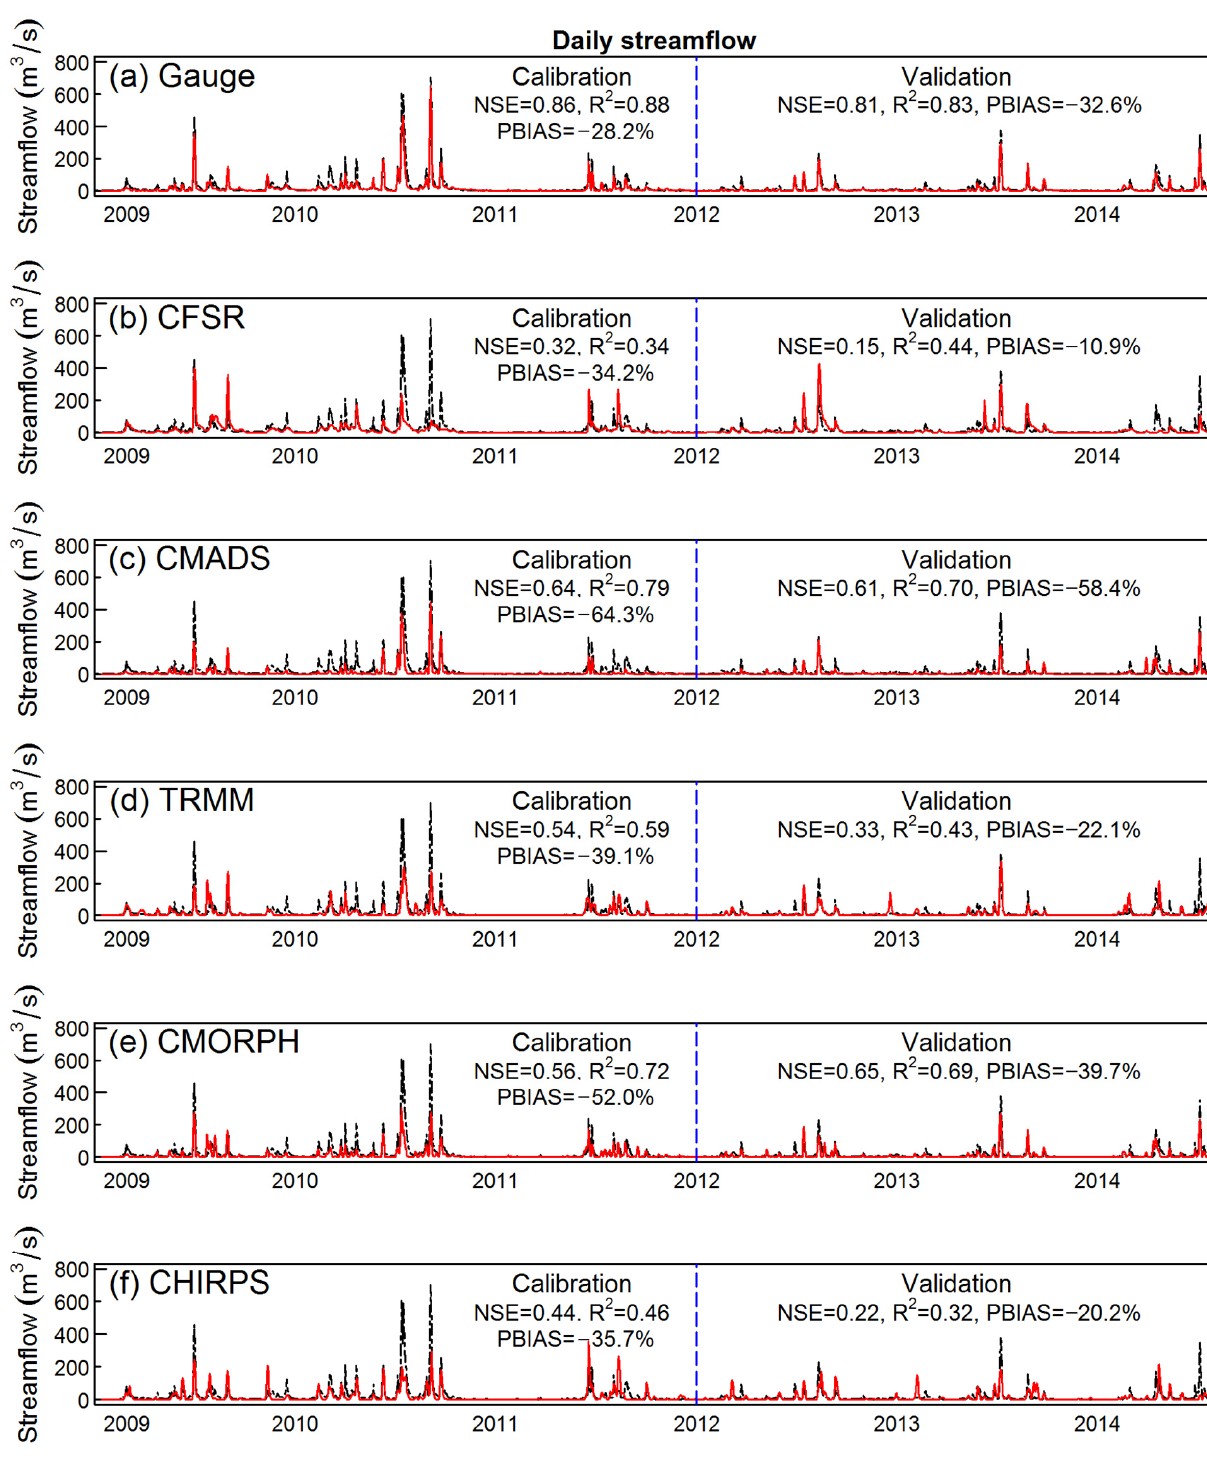
Figure 7. Comparison of daily measured (black line) and simulated (red line) streamflow from models using the CFSR meteorological (excluding precipitation) datasets and six different precipitation datasets for the period 2009–2014, including ( a ) Gauge, ( b ) CFSR, ( c ) CMADS, ( d ) TRMM, ( e ) CMORPH, and ( f ) CHIRPS.